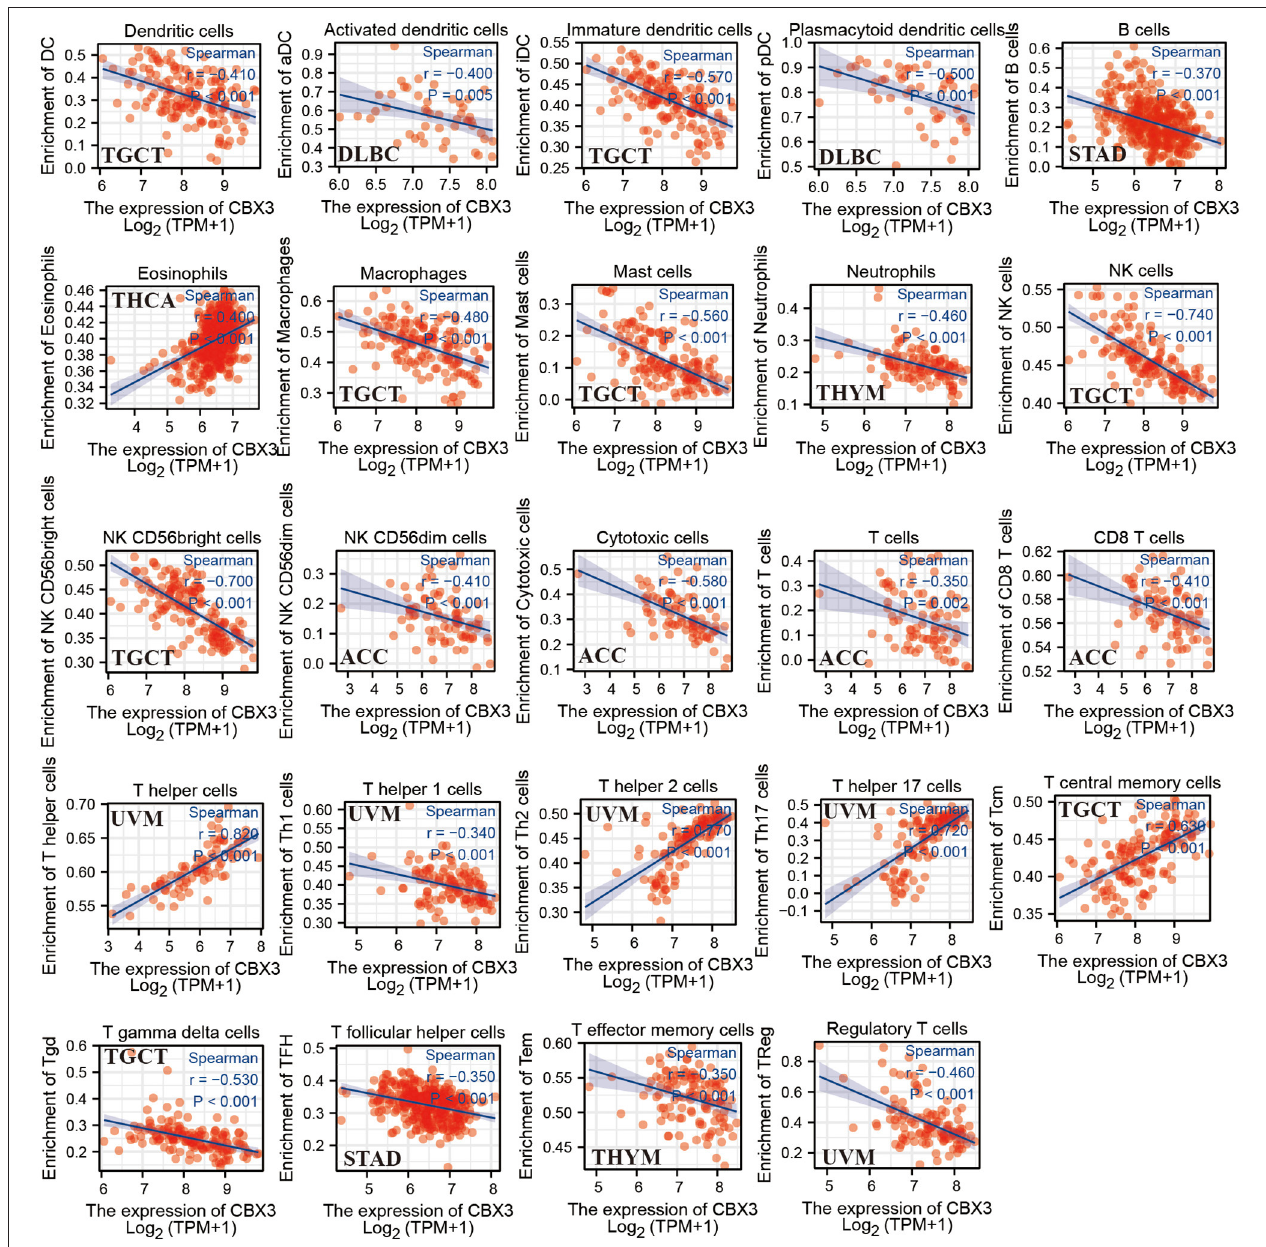
FIGURE 9 | Association between CBX3 expression and different tumor-infiltrating immune